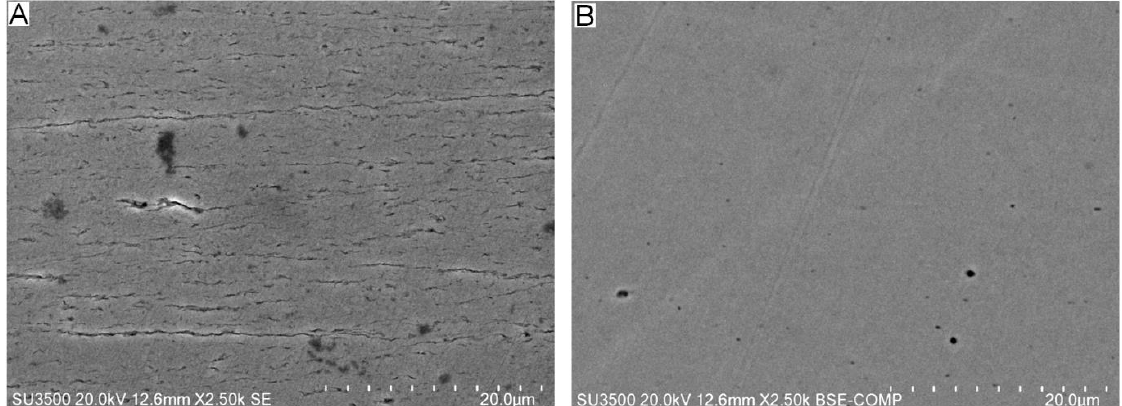
Figure 6. SEM images of the HSS surface after the cathodic treatment with a current density of − 25 mA/cm 2 and a duration of 25 h in 0.3 M Na 2 SO 4 at pH 2: ( A ) — the area with negative potentials, containing cracks; ( B ) — the area with positive potentials.